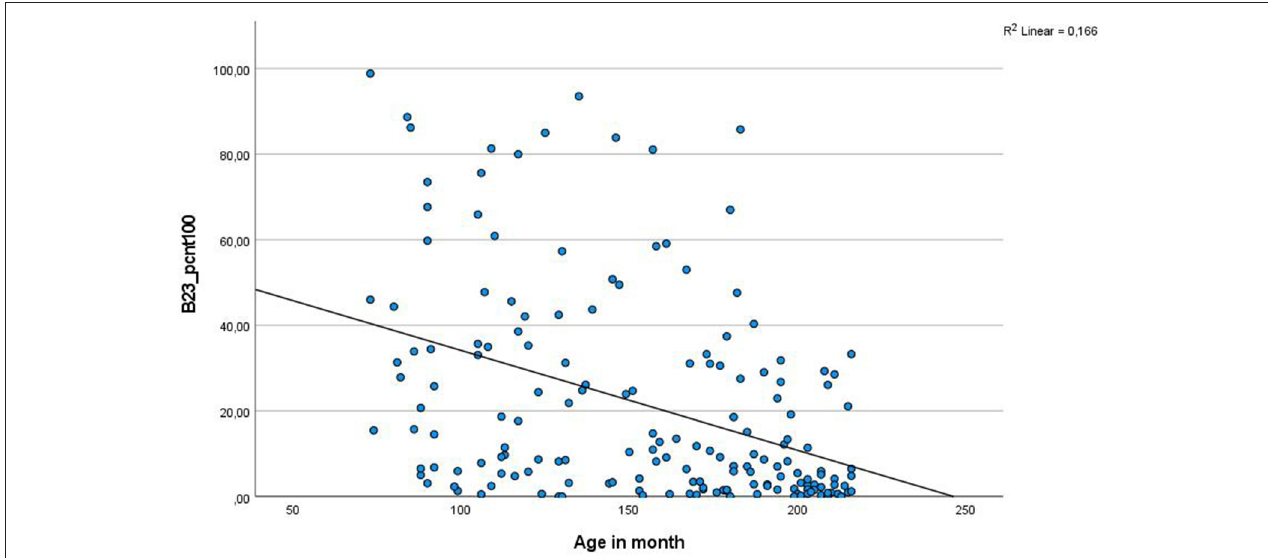
FIGURE 5 | Correlation between age and EEG vigilance stage B2/3. Here, the scatter plot between age and vigilance classification of stage B23 (drowsiness) of all eligible patients can be seen. The age drowsiness association is mainly due to the difference between the youngest and the eldest patients, but who also differed in their diagnosis in our study. Therefore, it is not decidable here whether this effect is caused by the diagnosis, by age, or by a mixture of both. The B23 difference was significant in all tested subsamples (see Table 4 ).